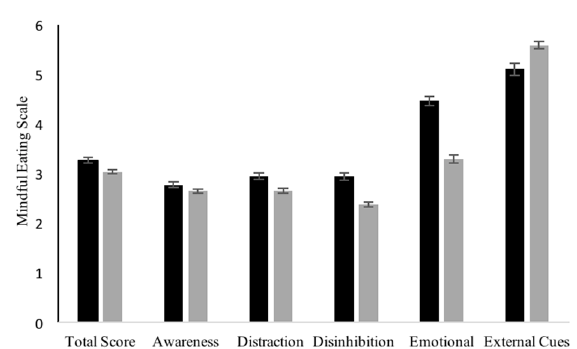
Figure 1. Differences between non-binge eaters and binge eaters in POMS total and subscales and mindful eating total scores and subscales (Mean ± SEM), * p < 0.05. POMS = Profile of Mood State